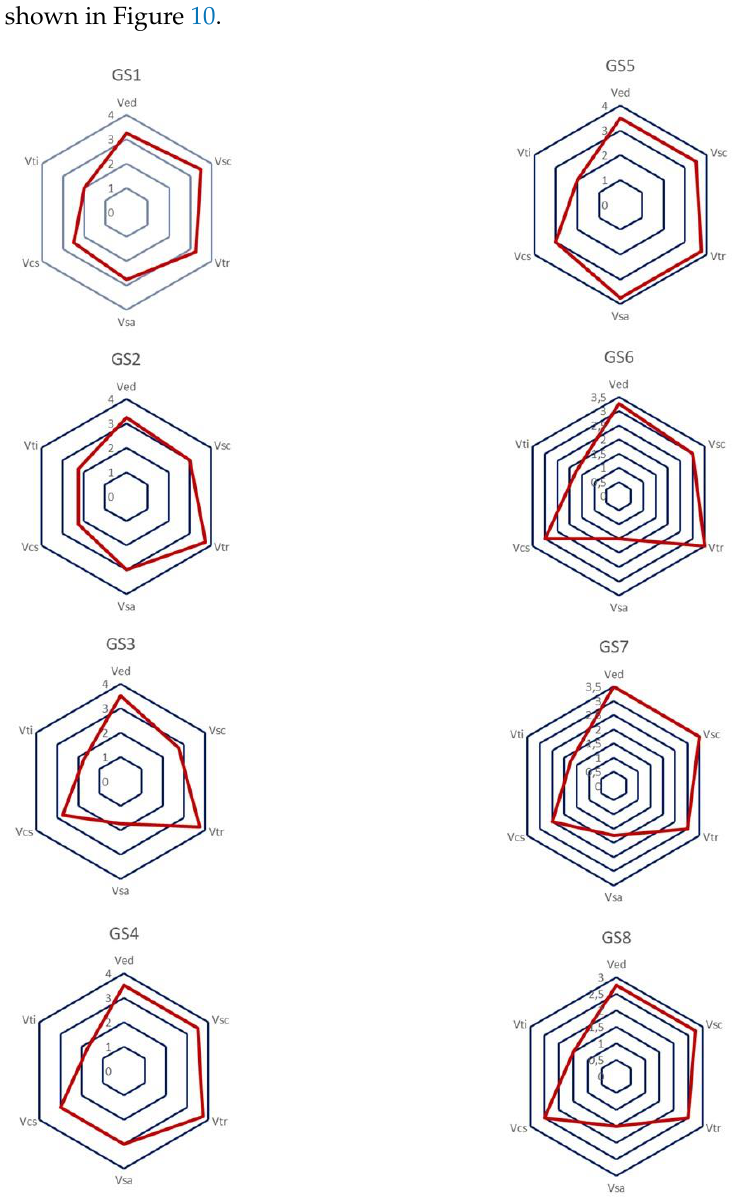
Figure 10. Radar diagrams which depict the axes scores for each geotope where Ved: educational value; Vsc: scientific value; Vtr: tourism value; Vsa: safety and accessibility assessment; Vcs: conservation-sustainability status and Vti: tourist information material.